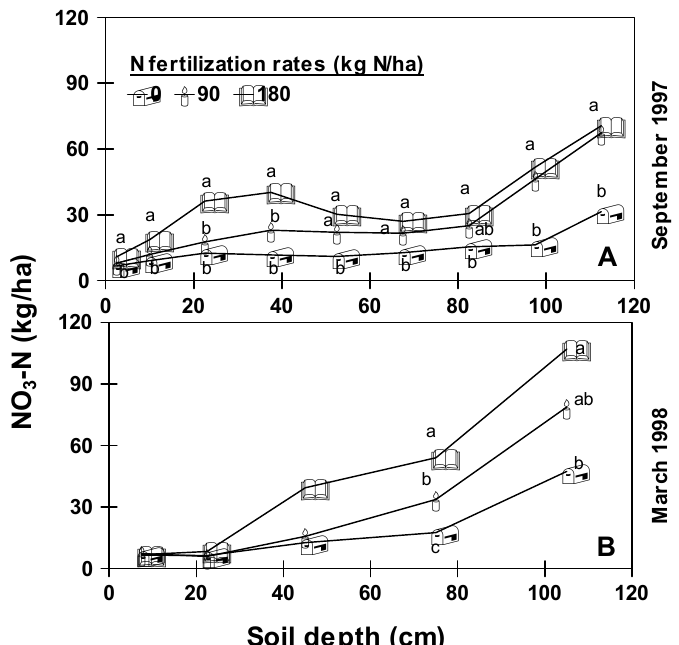
FIGURE 4. Soil NO 3 -N content with depth in autumn (September 1997) and spring (March 1998) as influenced by N fertilization rates. Nitrate content at a particular depth is plotted at the midpoint of the depth range. Symbols followed by different letter at a particular depth are significantly different at p < 0.05 by the least square means